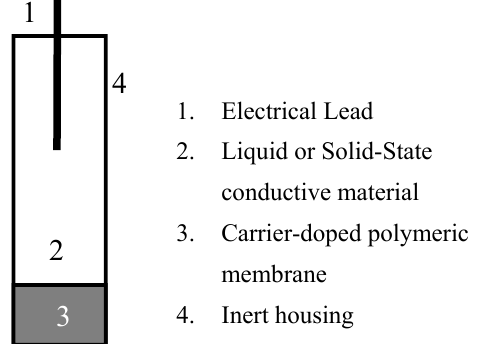
Figure 2. General design of a carrier-doped liquid-membrane electrode.